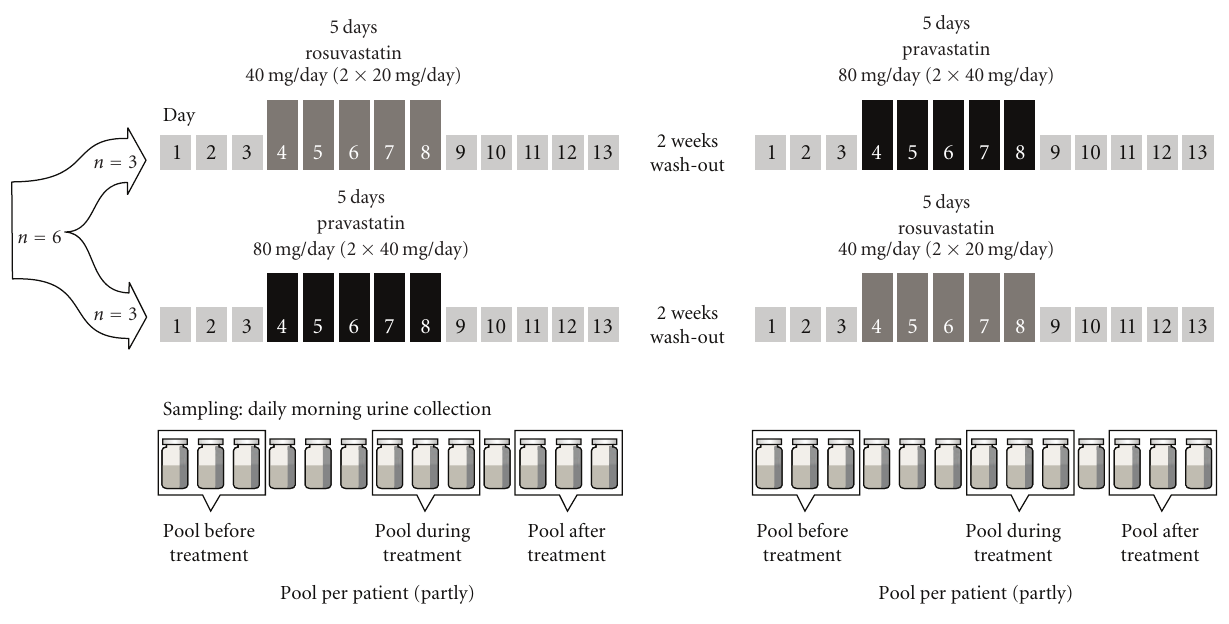
Figure 1: Schematic overview of the study